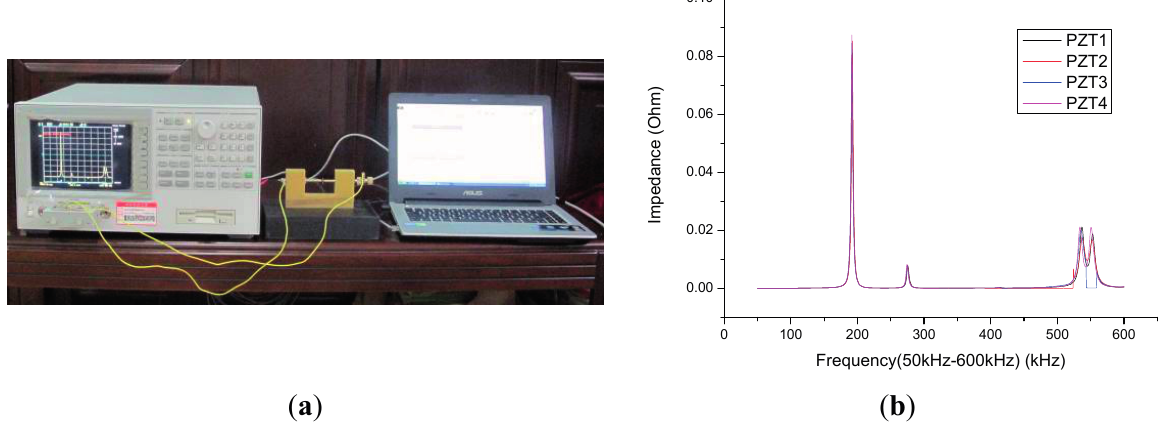
Figure 2. ( a ) Test equipment ( b ) Impedance curve of the bare PZT.